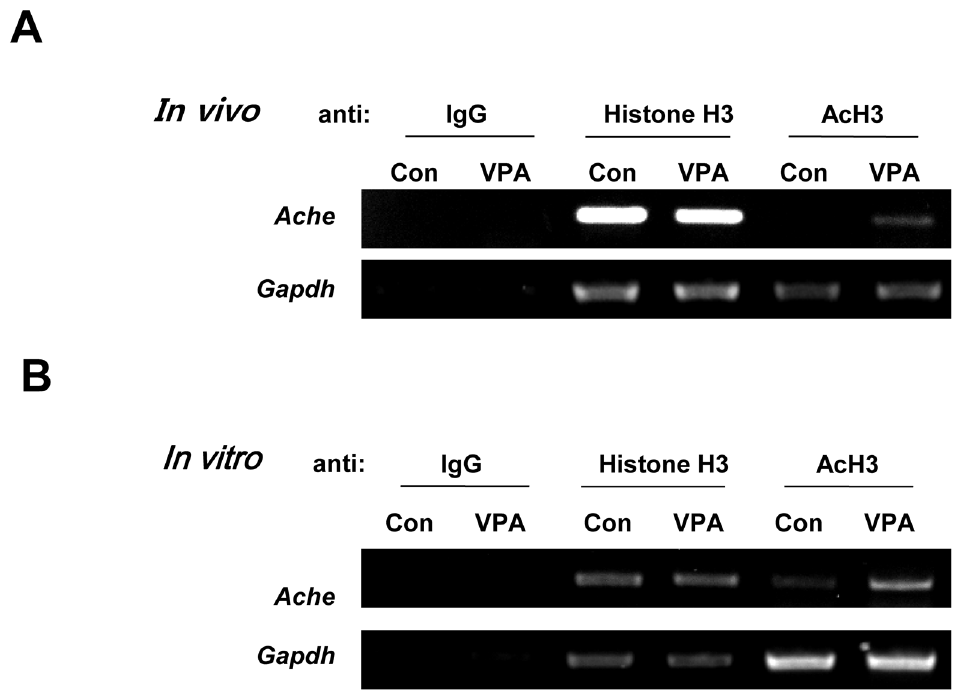
Figure 4. Acetylation of histone H3 bound to promoter region of Ache was increased by VPA treatment. To confirm the effect of HDACIs on the upregulation of AChE, ChIP was performed using prefrontal cortex from VPA rat and VPA treated cortical NPCs from SD rat. (A) ChIP results using prefrontal cortex of rat prenatally exposed to VPA or PBS (con) (B) ChIP results from cortical neural progenitor cells of rat. Gapdh was used as a positive control for this analysis. (AcH:acetylated Histone H3, Ache:acetylcholinesterase).